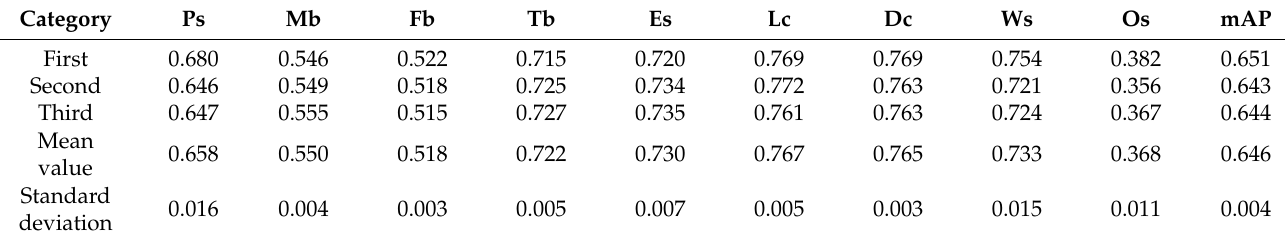
Table 4. AP values of various targets detected in experiment